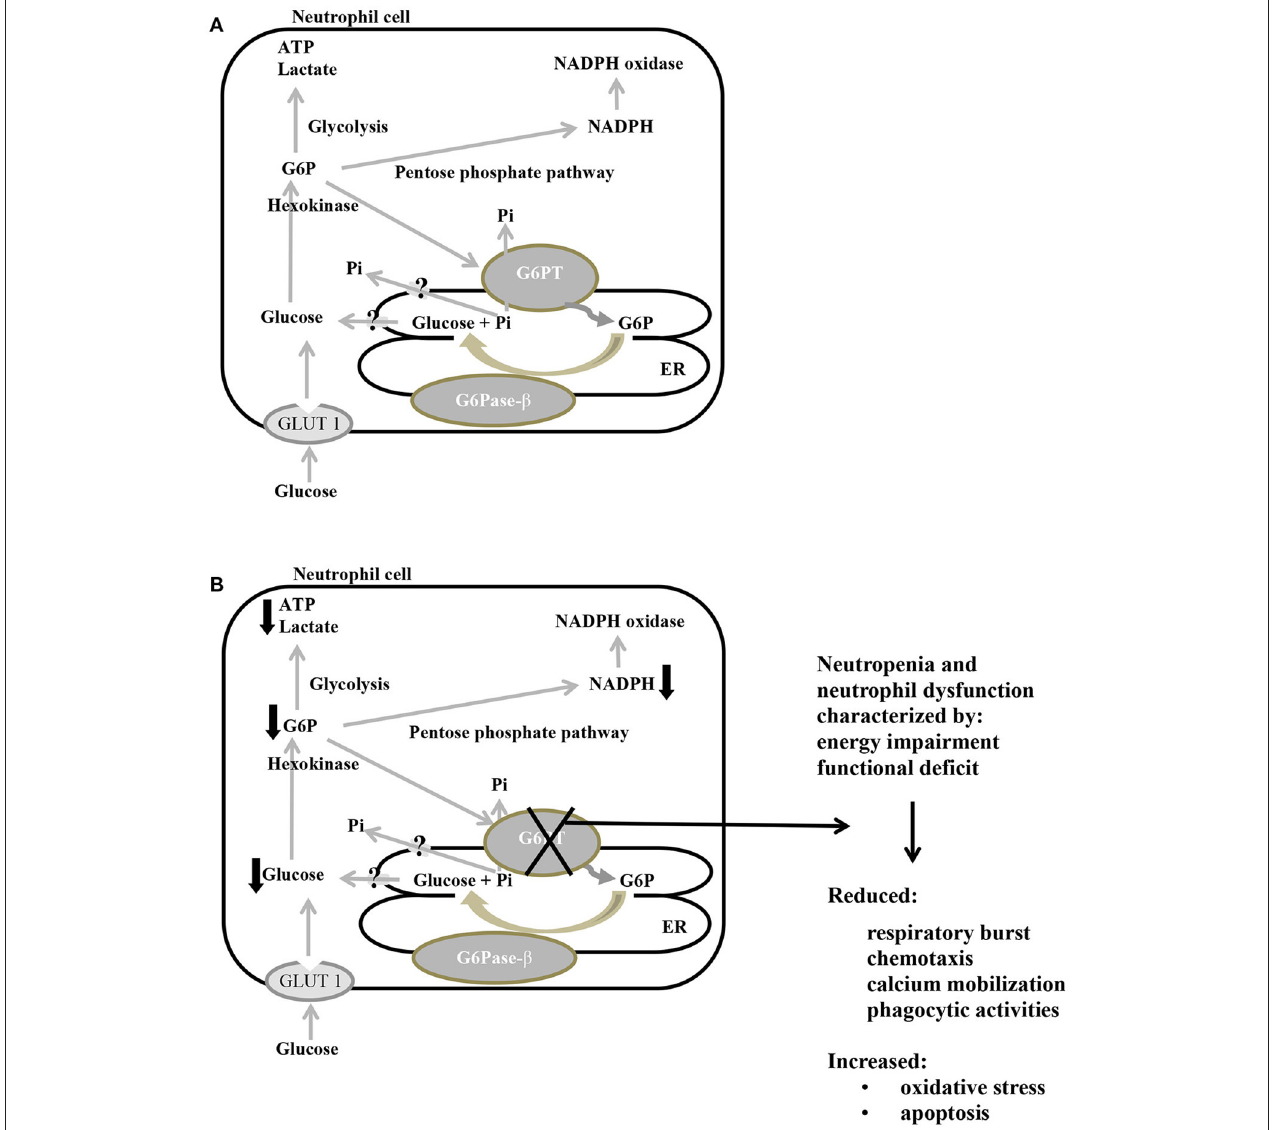
FIGURE 4 | Main metabolic pathways of G6P in normal (A) and defective G6PT (B) neutrophils. Schematic cell showing an extended endoplasmic reticulum (ER) and the three major pathways (glycolysis, pentose phosphate pathway, and ER cycling) in which G6P is involved. G6Pase- β and G6PT are embedded in the ER membrane; GLUT 1 is embedded in the plasma membrane. Black arrows indicate metabolic changes due to defective SLC37A4.: G6P, glucose-6-phosphate; G6Pase- β , glucose-6-phosphatase- β ; G6PT, glucose-6-phosphate translocase; GLUT 1, glucose transporter 1; P, phosphate; Pi, inorganic phosphate; ATP, adenosine triphosphate; NADPH, nicotinamide adenine dinucleotide